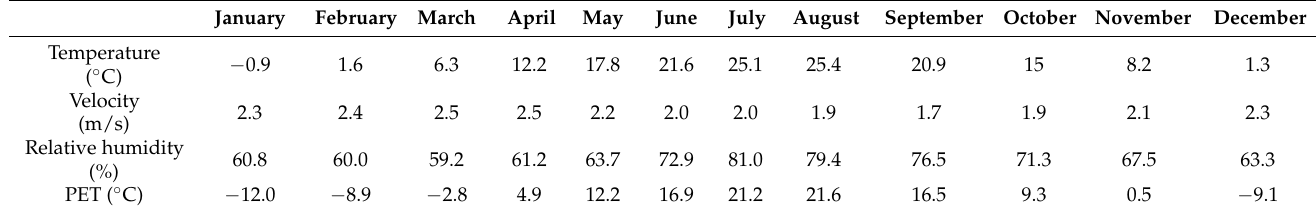
Table 4. Climate information and PET in South Korea for 10